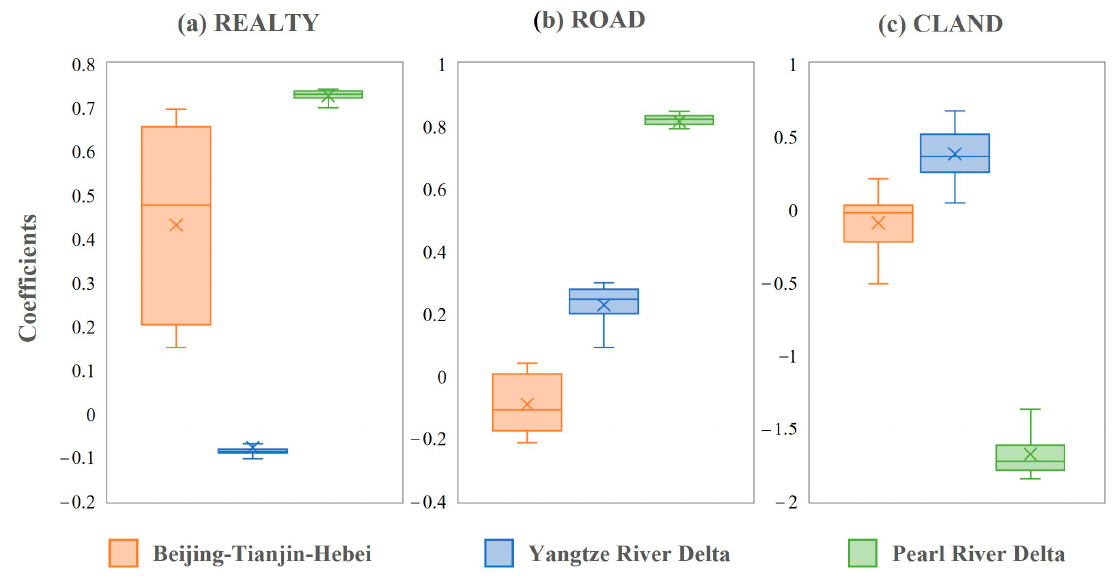
Figure 8. Box plots of the spatial coefficients of REALTY, ROAD, and CLAND on five urban ag- glomerations in